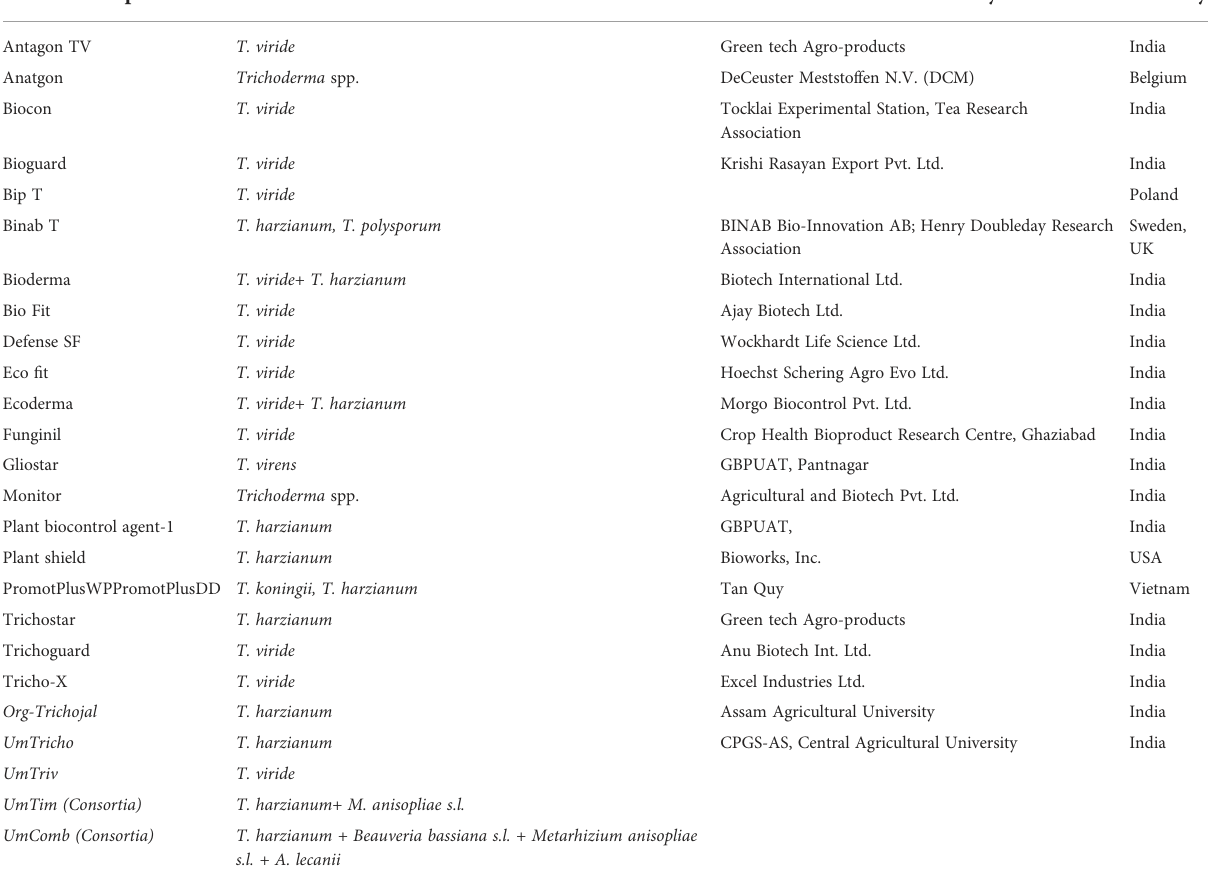
TABLE 4 Commercial formulation of Trichoderma